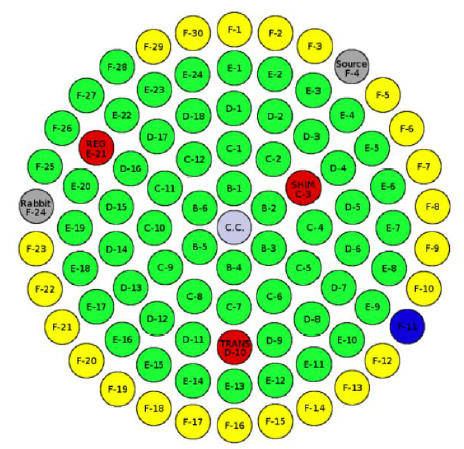
Figure 1: Triga Mark II Reactor element disposition: fuel rods (green), control rods (red), graphite reflector rods (yellow), experimental/source channels (grey), empty slots